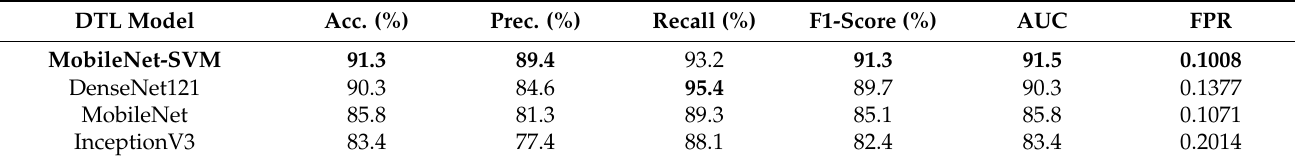
Table 7. Performance analysis of the proposed MobileNet-SVM on the BCH dataset.